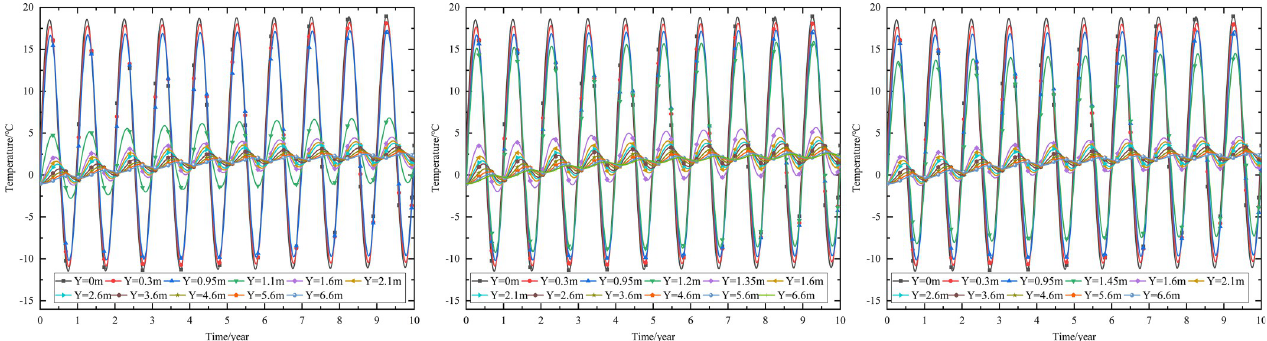
Fig 10. Temperature-time curves of pavement center with the installation layer at (a) the top of the subbase layer, (b) the middle of the subbase layer, and (c) the bottom of the subbase layer.